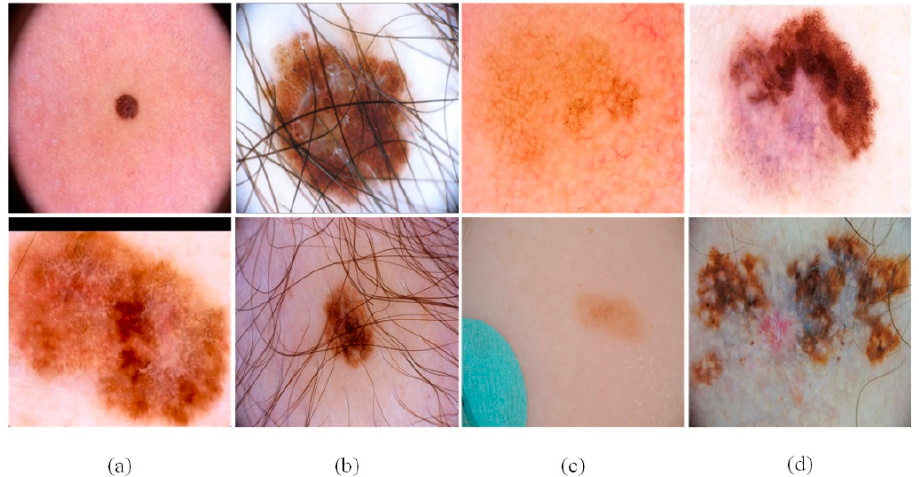
Figure 6. The challenges of skin lesion segmentation: ( a ) irregular lesion area, ( b ) case with fair and air bladder in lesions, ( c ) small changes between normal skin and skin lesion, and ( d ) the stratified features of the lesions.